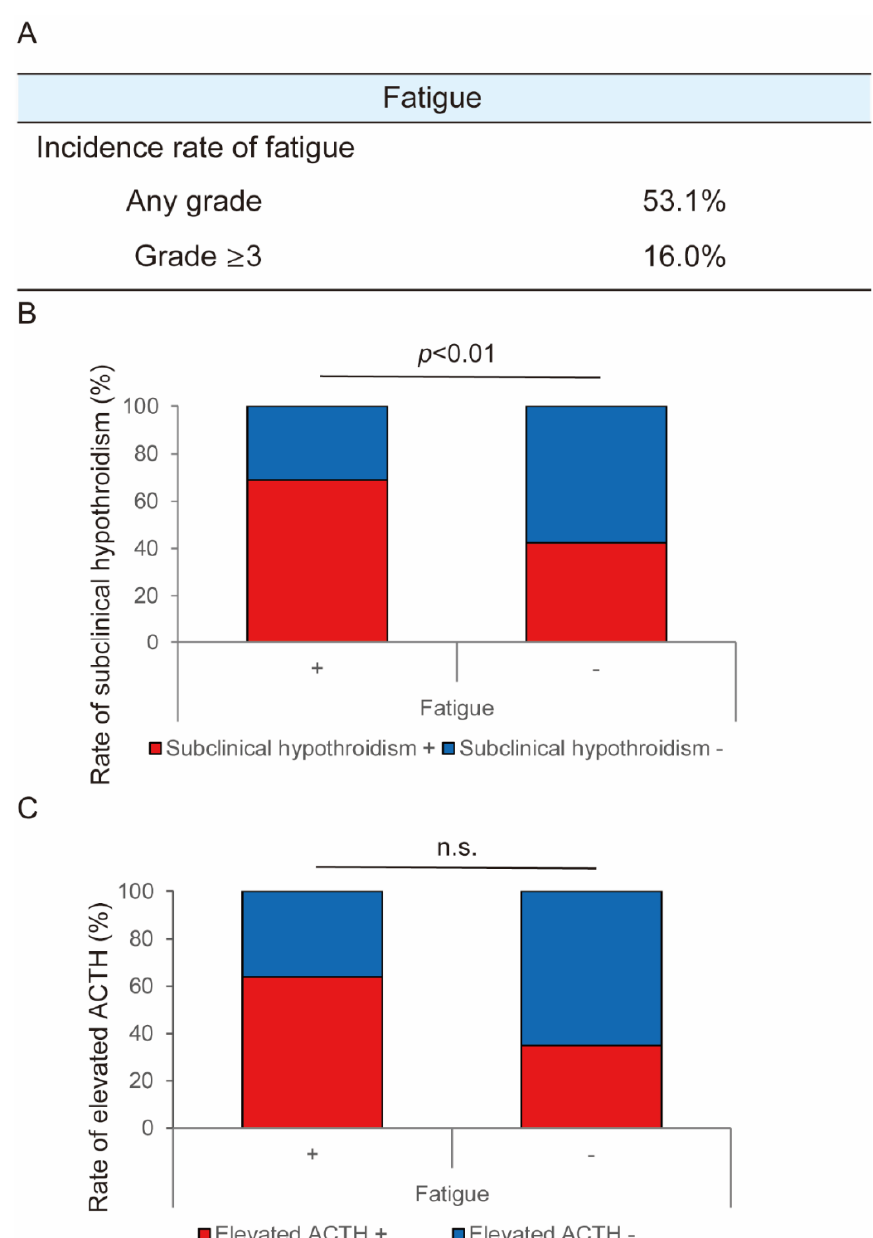
Figure 2. Analysis of lenvatinib-induced fatigue. ( A ) Incidence rate. ( B ) Correlation between fatigue and thyroid function (fatigue was significantly correlated with subclinical hypothyroidism). ( C ) Association between fatigue and adrenal function (fatigue was not significantly correlated with elevated acetylthiocholine iodide (ACTH)). n.s.: not significant.